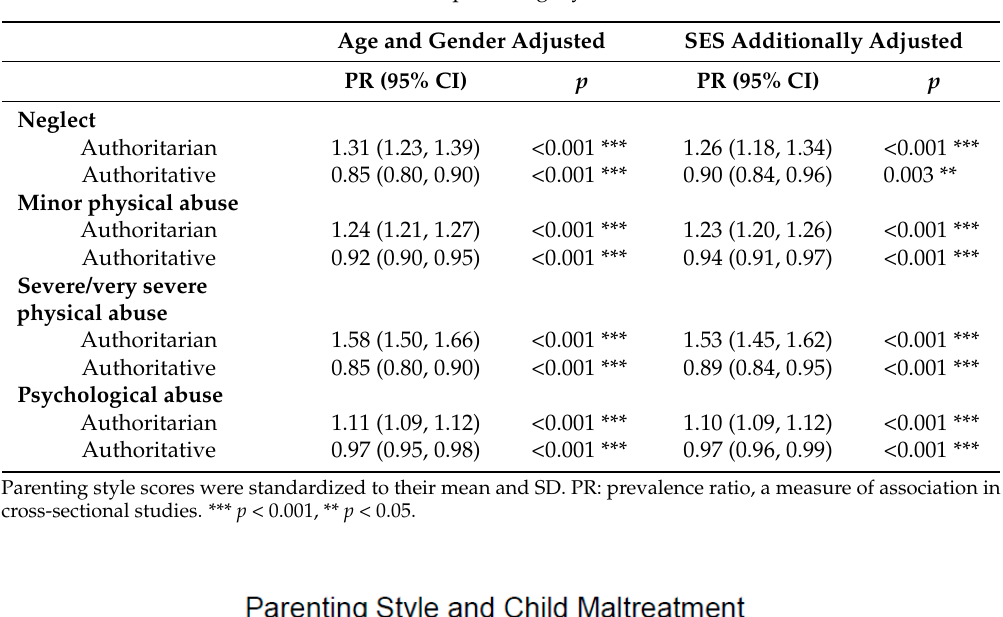
Figure 1. Association between categories of parenting style and child maltreatment.